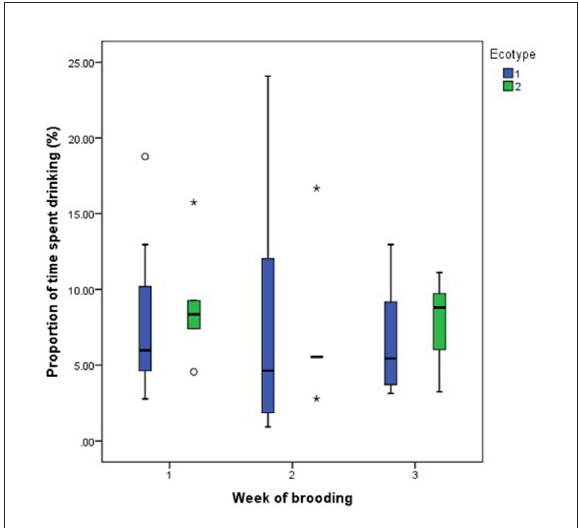
FIGURE6 Proportion of time spent by two Nigerian indigenous hen ecotypes (1 = Yoruba and 2 = Fulani) drinking over the three weeks of brooding. Outliers in the data are depicted by the symbol “* or ◦ ”.